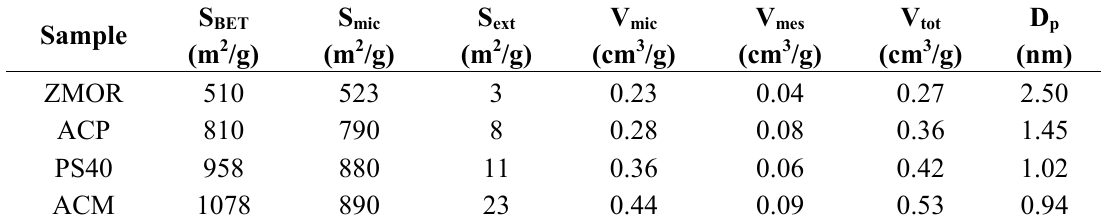
Table 1. Physical properties deduced from N in this